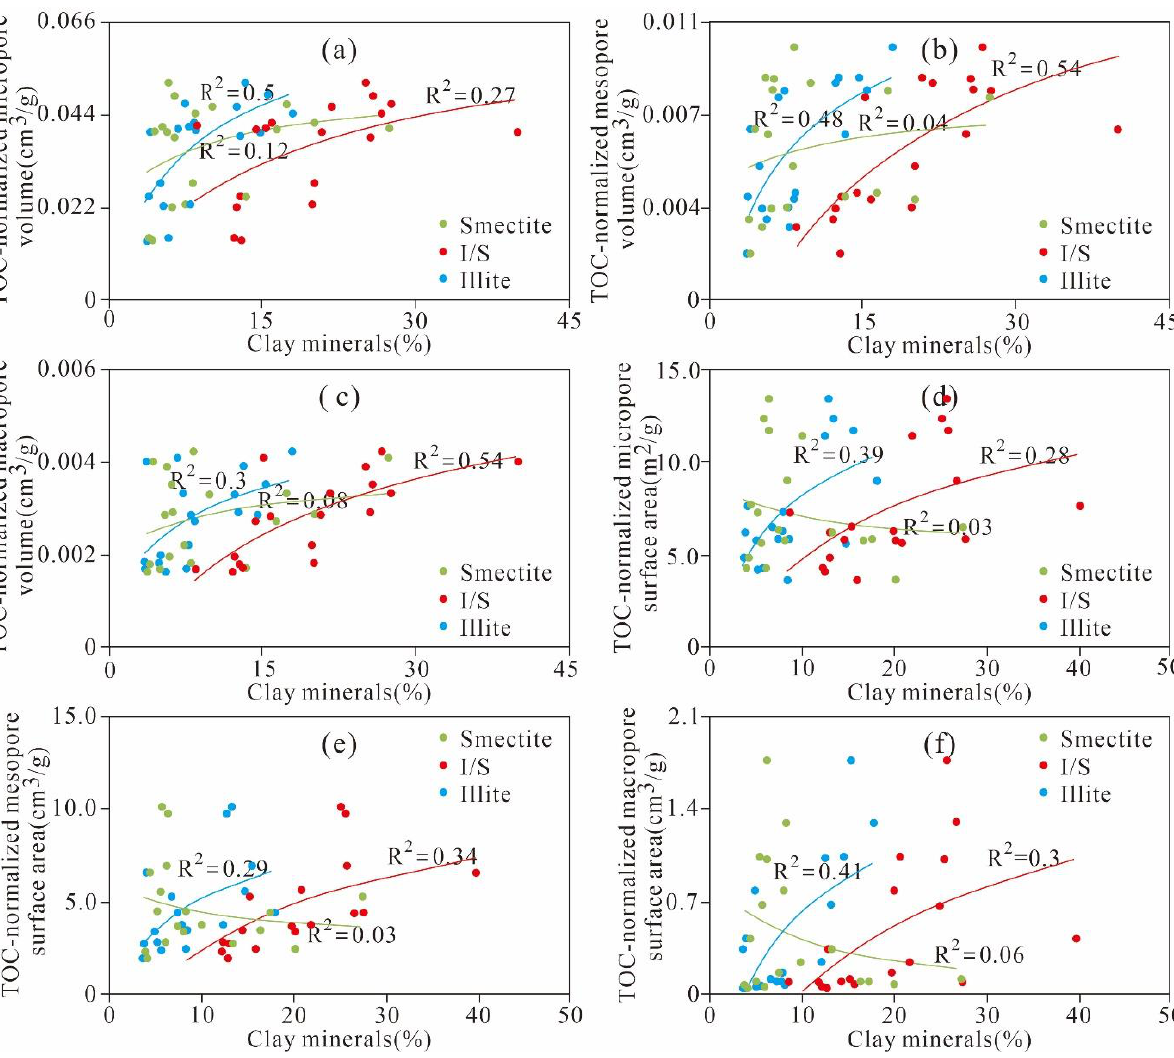
Figure 13. Different clay mineral compositions versus the TOC-normalized PV of the ( a ) micropores, ( b ) mesopores, ( c ) macropores and the TOC-normalized SA of the ( d ) micropores, ( e ) mesopores, ( f ) macropores.